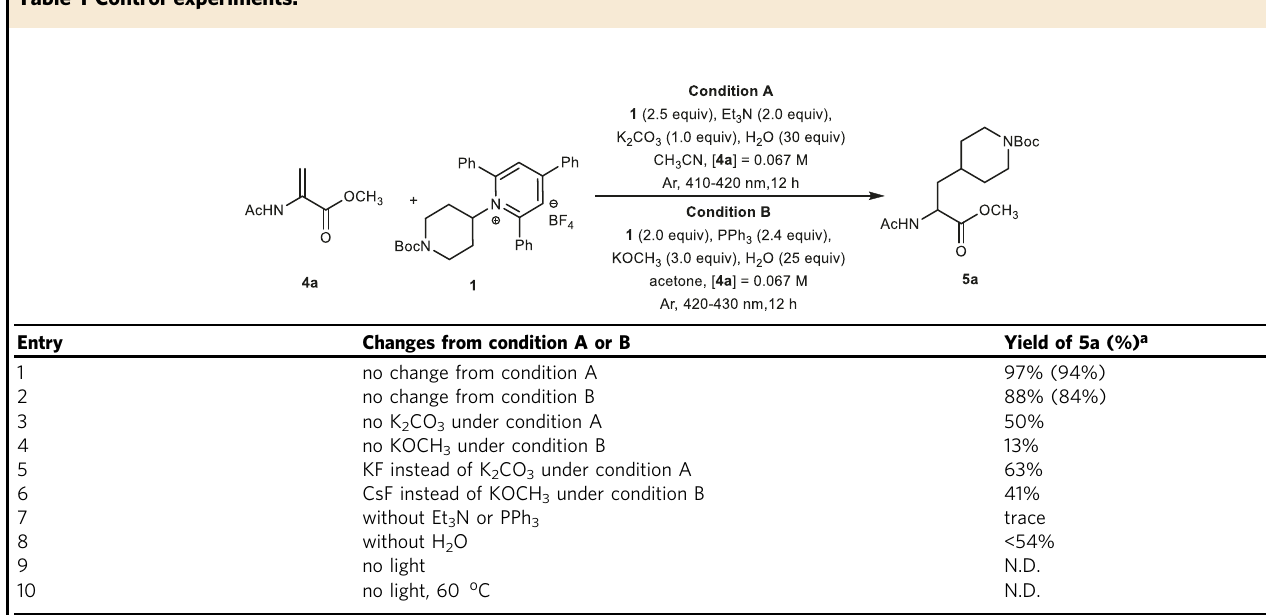
Table 1 Control